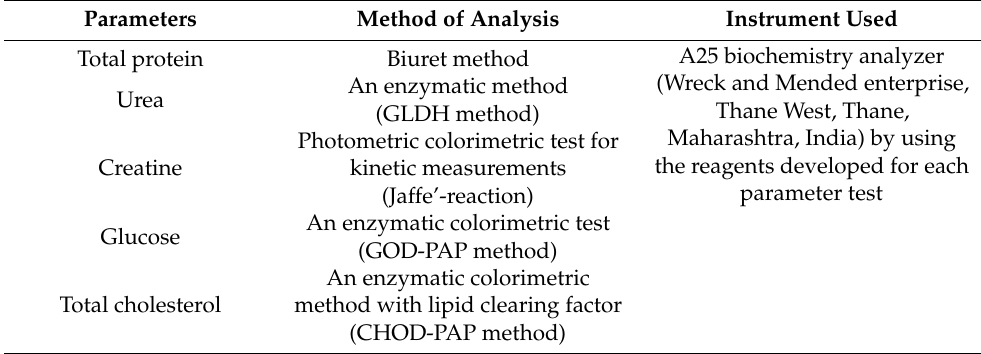
Table 1. Serum sample and analysis